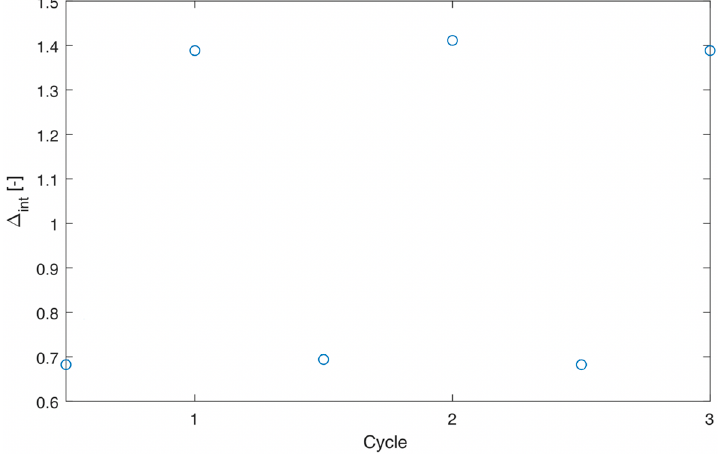
Figure 10. Plot showing temperature-cycle measurements for α -MoO 3 :Er 3+ , Yb 3+ .